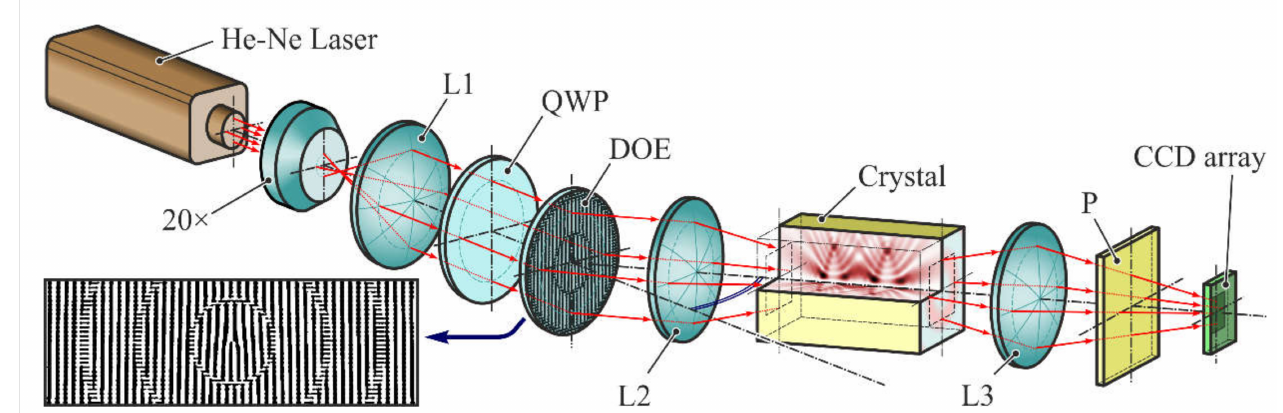
Figure 4. Optical system for generation of vector OV beams by a combination of DOEs and anisotropic crystals: a He-Ne laser emitting linearly polarized light which was expanded using an objective (L1), a quarter-wave plate (QWP) was utilized to alter the linearly polarized beam into the circularly polarized beam, the diffractive optical element (DOE) generates OV Laguerre-Gaussian modes which are focusing by a lens (L2) into a c-cut CaCO 3 crystal, cylindrically polarized beams (with radial or azimuthal polarization) are imaging by a lens (L3) at CCD array and analyzed by a polarizer (P). Reprinted with permission from ref. [115]. Copyright 2017,